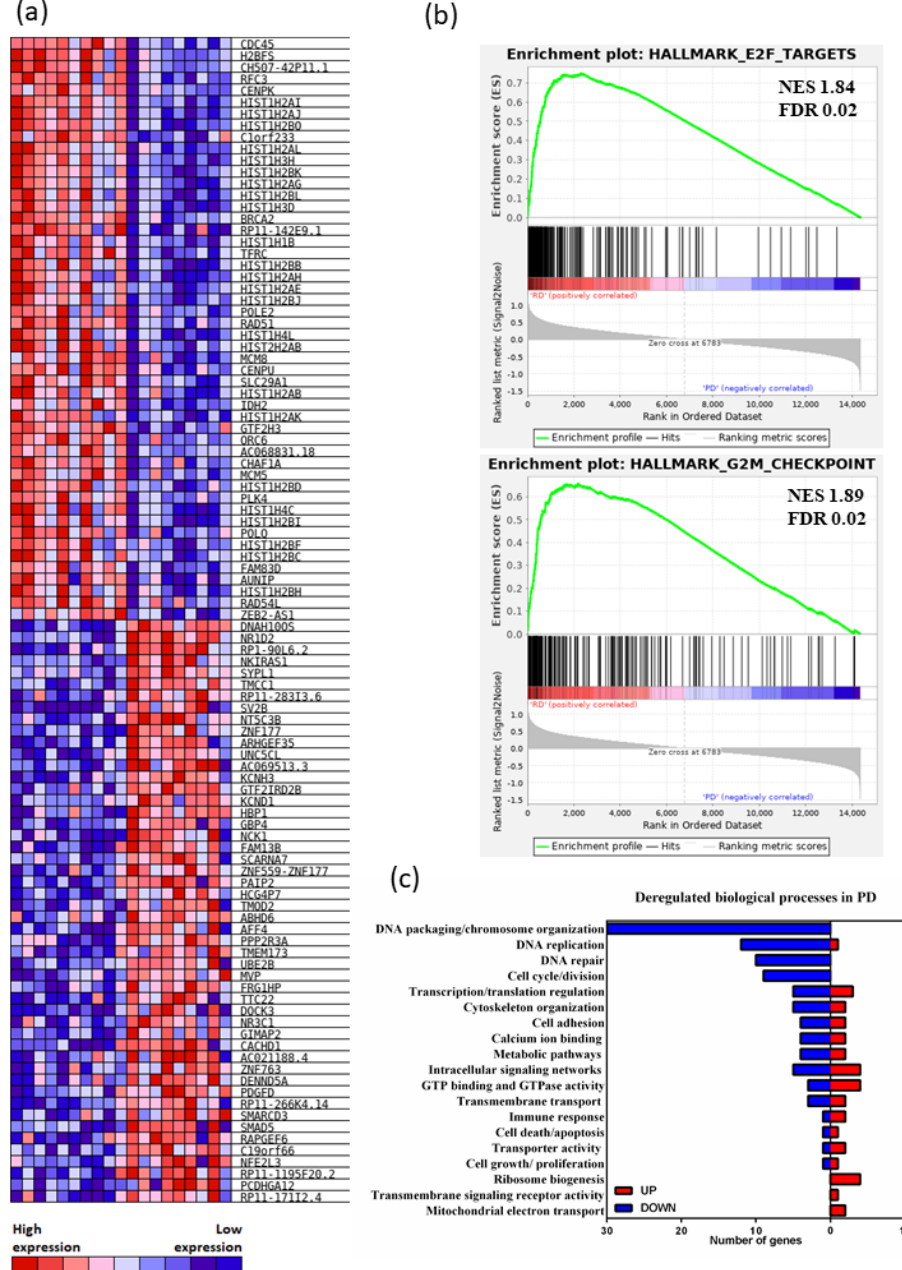
Figure 2. ( a ) Heatmap showing the top 50 up and downregulated genes in AZA-responders (RD) and patients with disease progression (PD), ranked by gene set enrichment analysis (GSEA). ( b ) GSEA indicating selected gene sets enriched in RD vs. PD patients’ groups (the top GSEA: Hallmark E2F targets gene set (MSigDB ref: M5925), the bottom plot: Hallmark G2/M checkpoint gene set (MSigDB ref: M5901)). The normalized enrichment scores (NES) and associated FDR values are depicted within the individual plots. ( c ) Functional annotation of 85 downregulated (blue) and 58 upregulated (red) differentially expressed genes in PD vs. RD patients’ groups (FDR < 0.02